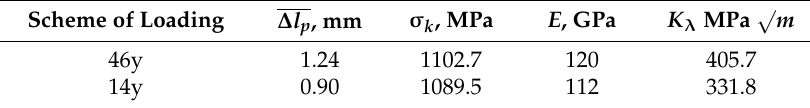
Table 6. Value of crack resistance parameter K λ for the VT23M alloy in different